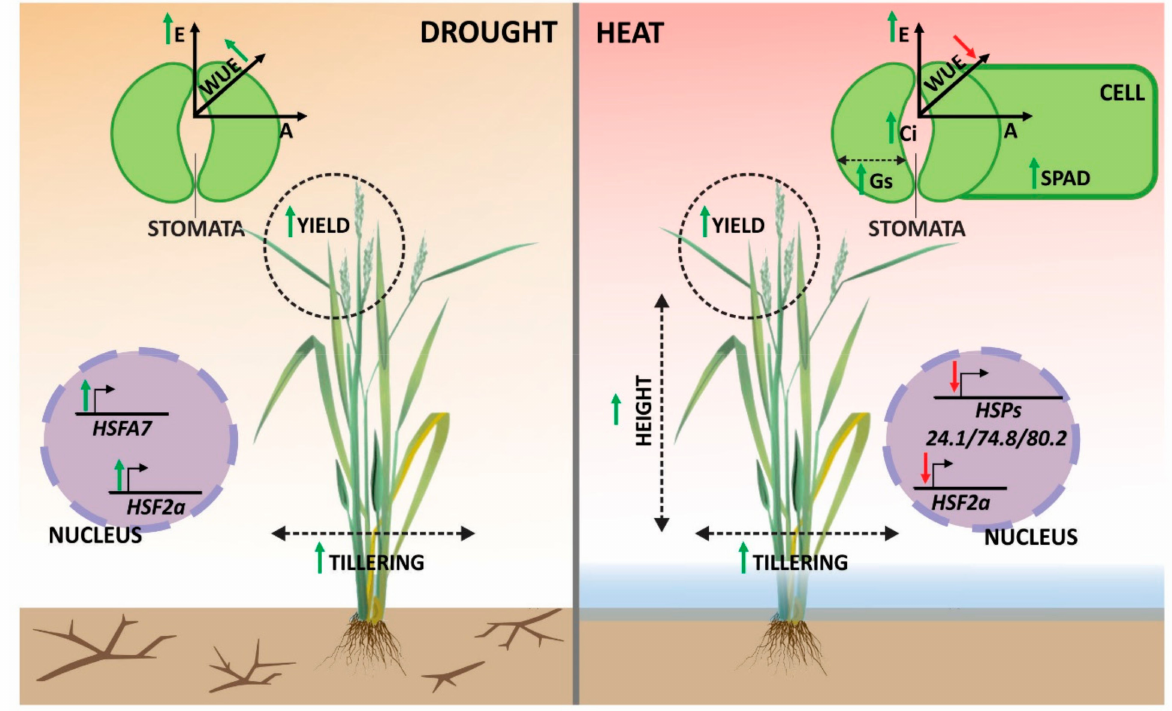
Figure 7. Proposed model of morphology, photosynthetic, and molecular responses for suitable performance in drought and heat stress conditions for rice and weedy rice plants. Red arrows mean decrease, and green arrows mean